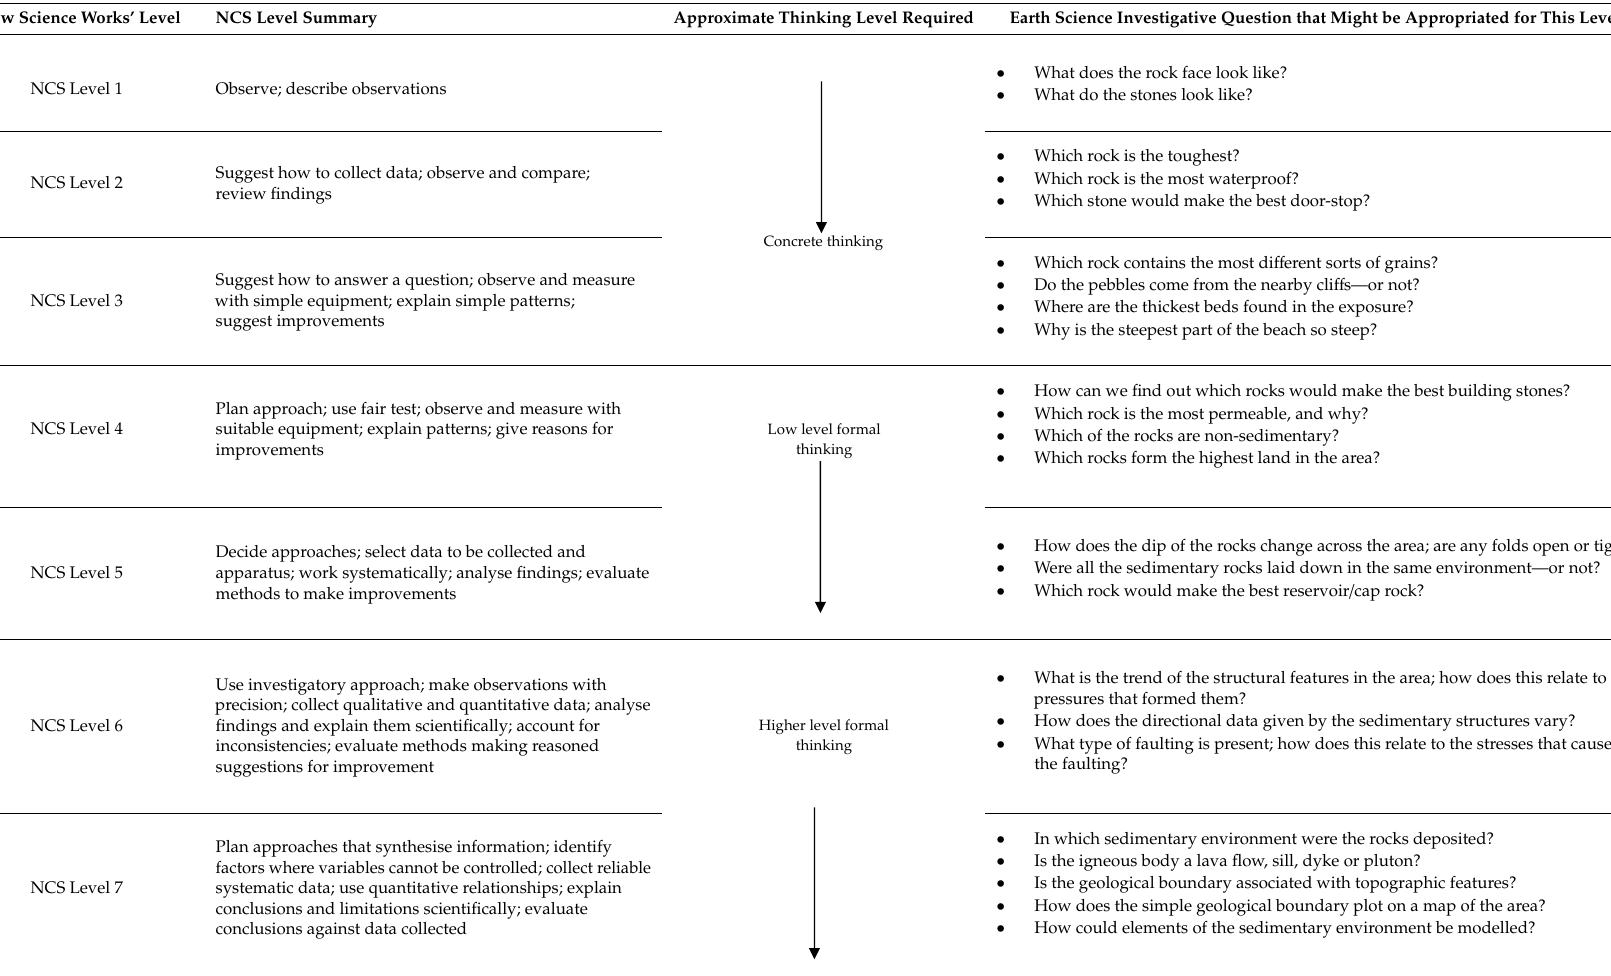
Table 5. Suggested Earth science investigative questions forming a teaching sequence through the ‘How science works’ levels identified through the National Curriculum for Science (NCS), with additions, as explained for Table 1.